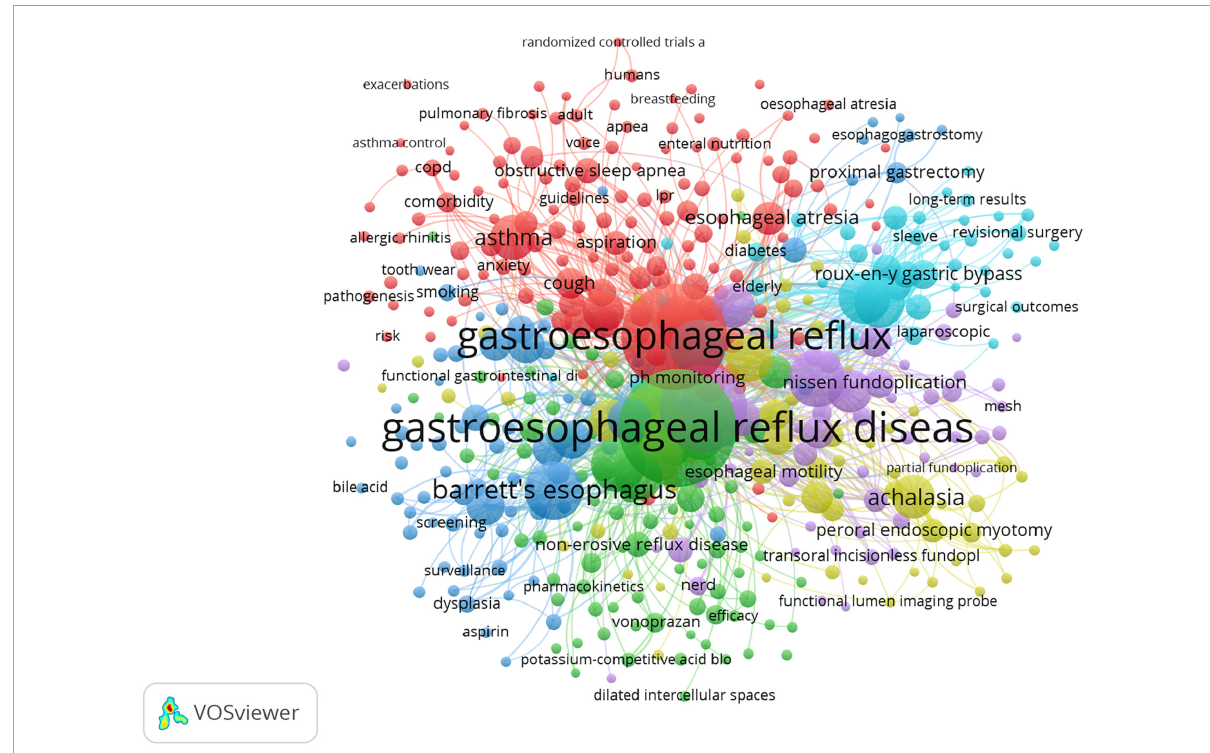
FIGURE5 Map of keyword clustering with a minimum of 10 occurrences in GERD research. Minimum number of occurrence of a keyword = 10, minimum links strength = 10. There are 6 clusters of